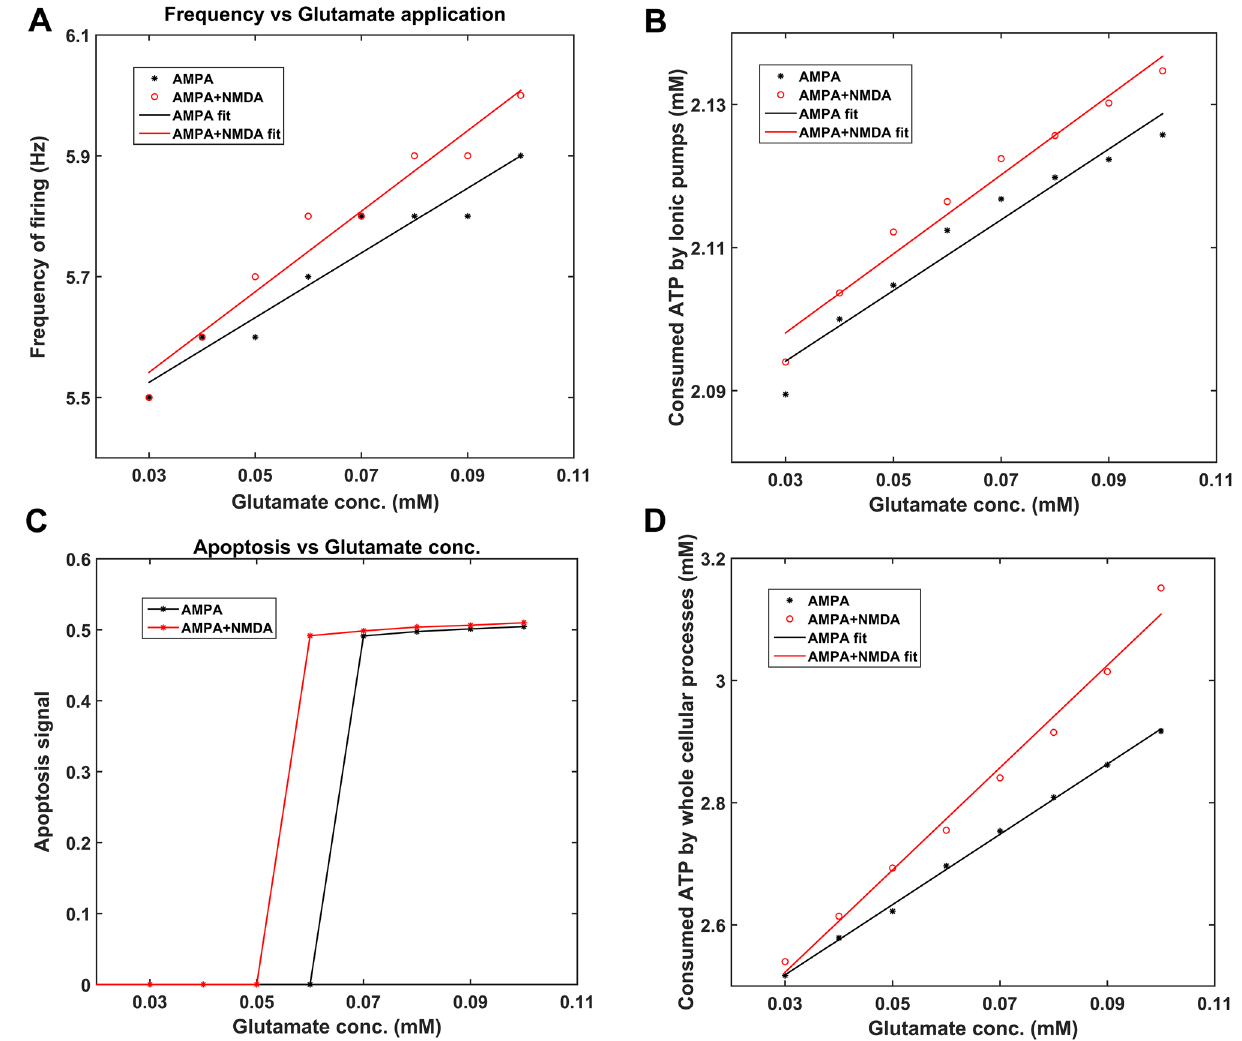
Figure 4. Model response to chemical stimulation (glutamate). Frequency of firing ( A ), Apoptosis signal ( C ) due to excess stimulation, Energy consumption by ionic pumps ( B ) and all other (whole) cellular processes ( D ) of the model concerning the concentration of glutamate application (1 s). ATP Adenosine triphosphate, AMPA alpha-amino-3-hydroxy-5-Methyl-4-isoxazole propionic acid, NMDA N -methyl-d-aspartic acid, Hz Hertz, mM